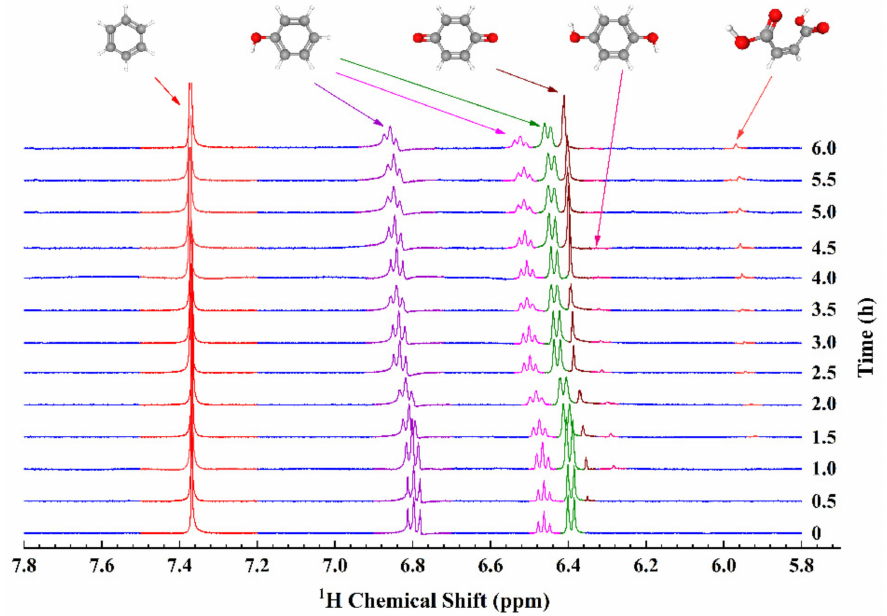
Figure 4. Time resolved in situ 1 H EC-qNMR study of EAOPs in 10 mM phenol + 0.1 M H 2 SO 4 at +1.1 V (vs. Ag/AgCl), the external standard is 25 mM benzene +